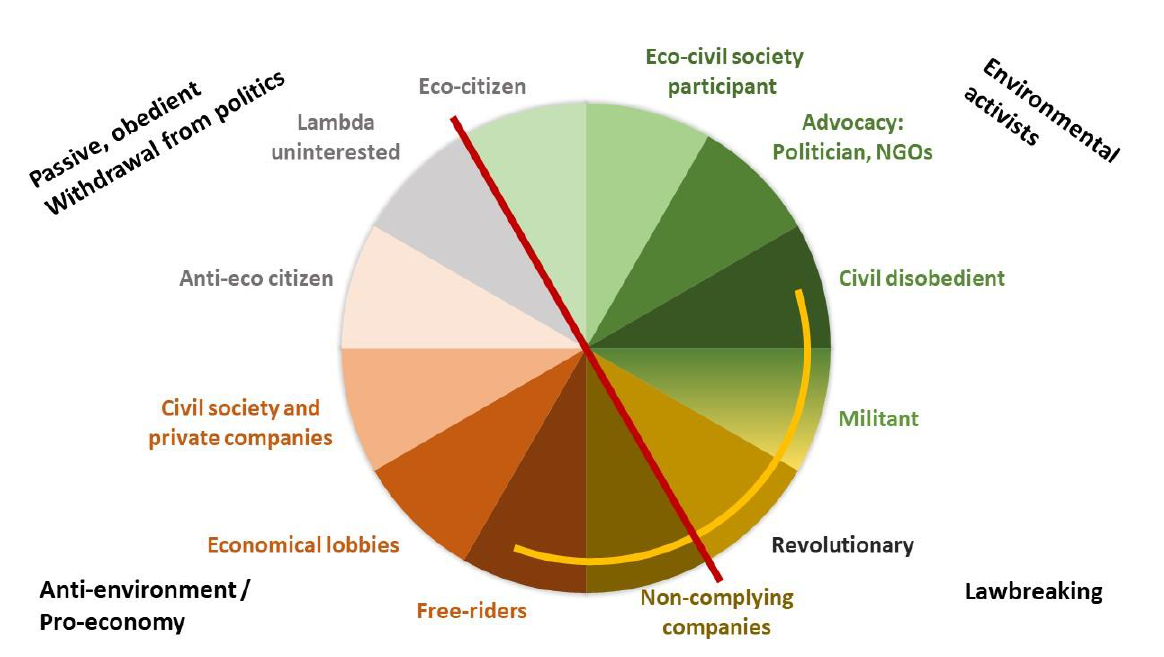
Figure 1: Typology of the positions that can be taken relative to environmental issues, from the perspective of environmental activists. Note: Figure created by the